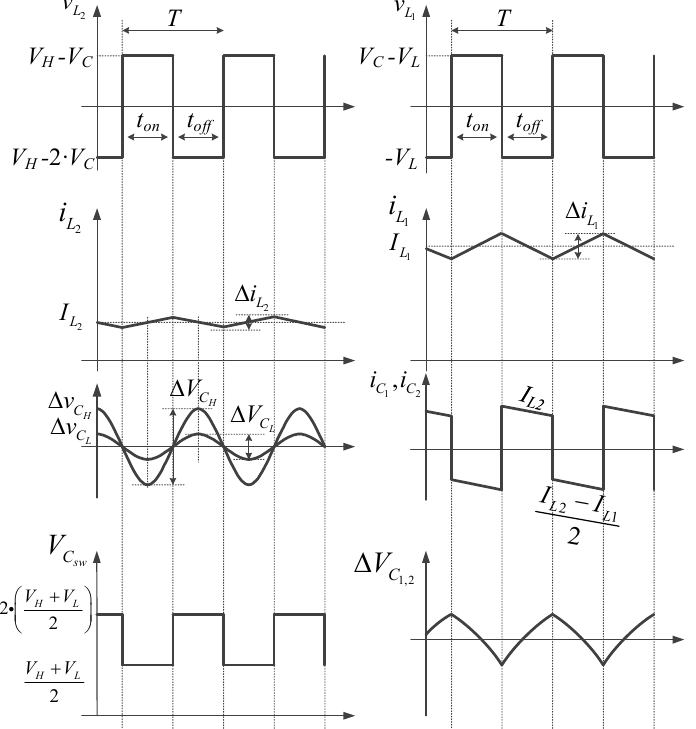
Figure 5. Main theoretical waveforms of the BHSC for steady-state, step-down operating